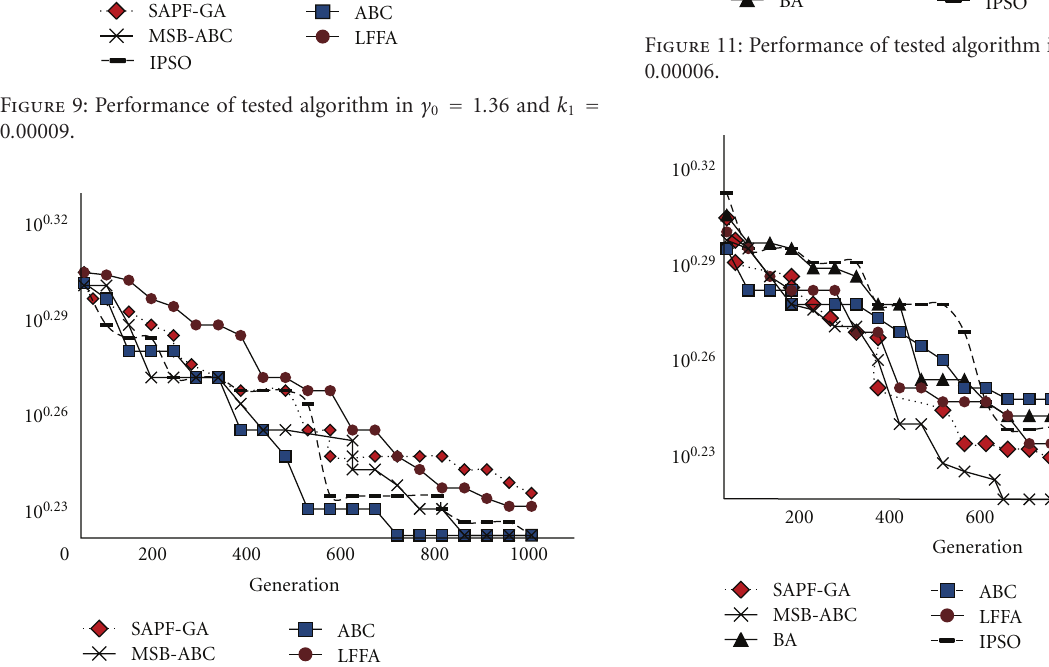
Figure 12: Comparison of performance of SPFA-GA, L-FFA, I-PSO, BA, ABC, and MSB-ABC in e ffi ciency analyzing of the Atkinson